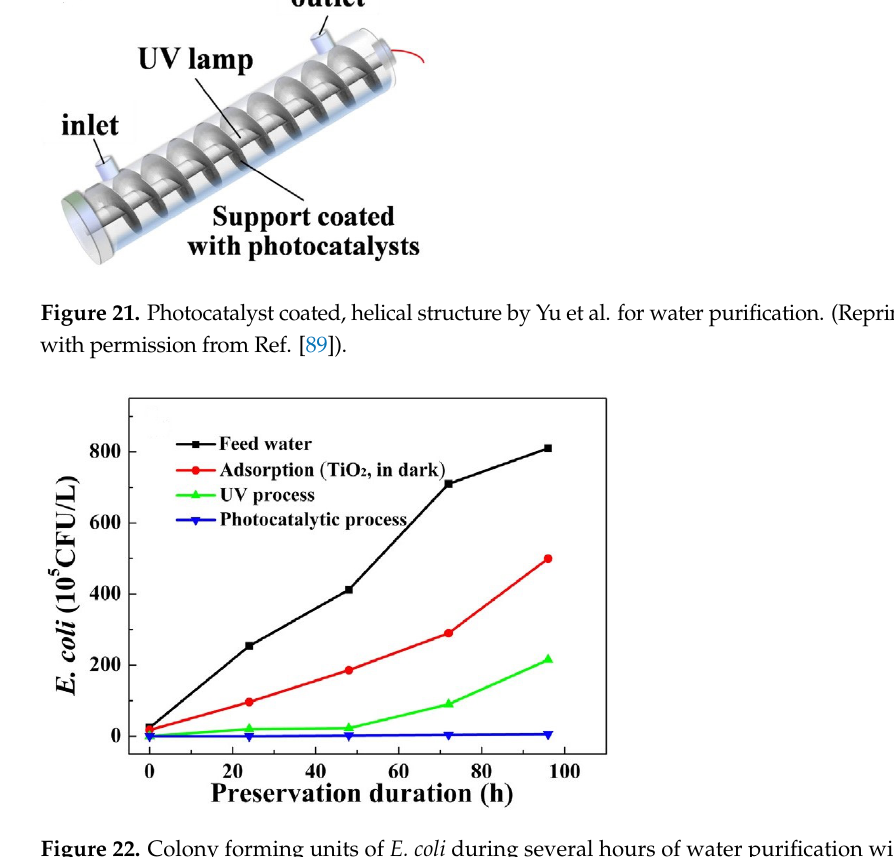
Figure 22. Colony forming units of E. coli during several hours of water purification with the reactor developed by Yu et al. (Reprinted/adapted with permission from Ref.